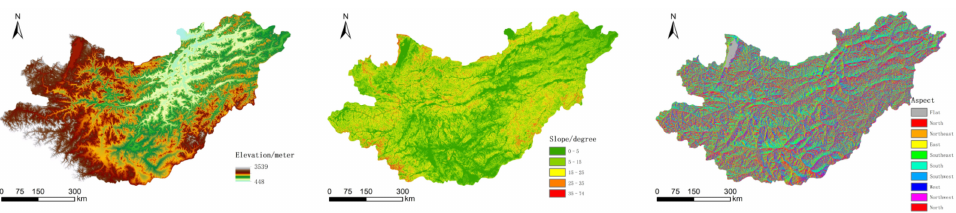
Figure 5. Elevation, slope, and aspect raster data in the basin.